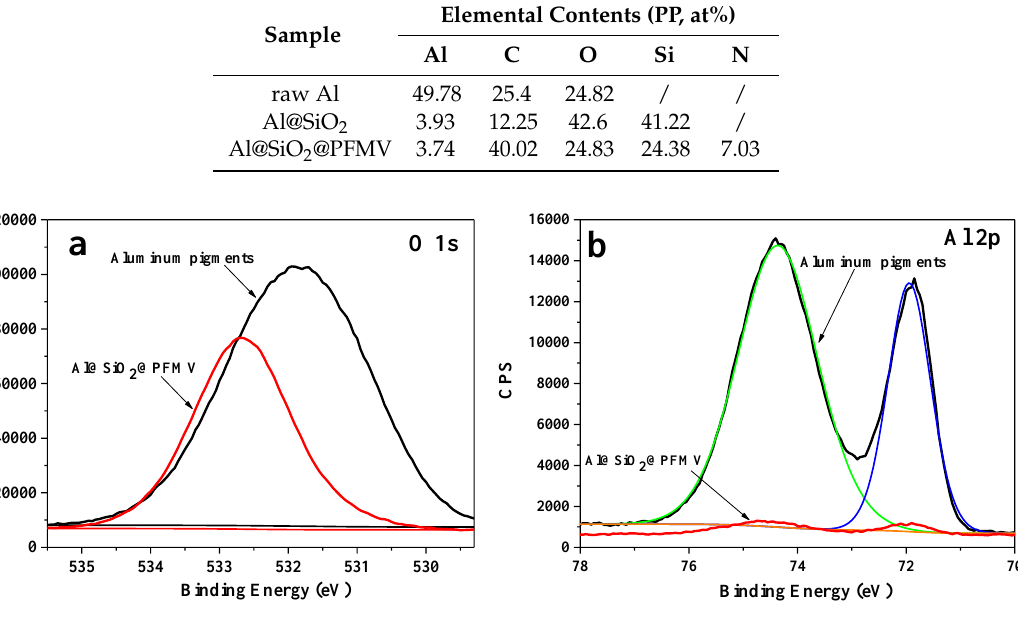
Figure 6. High-resolution XPS spectrum of O 1s ( a ) and Al 2p ( b ).